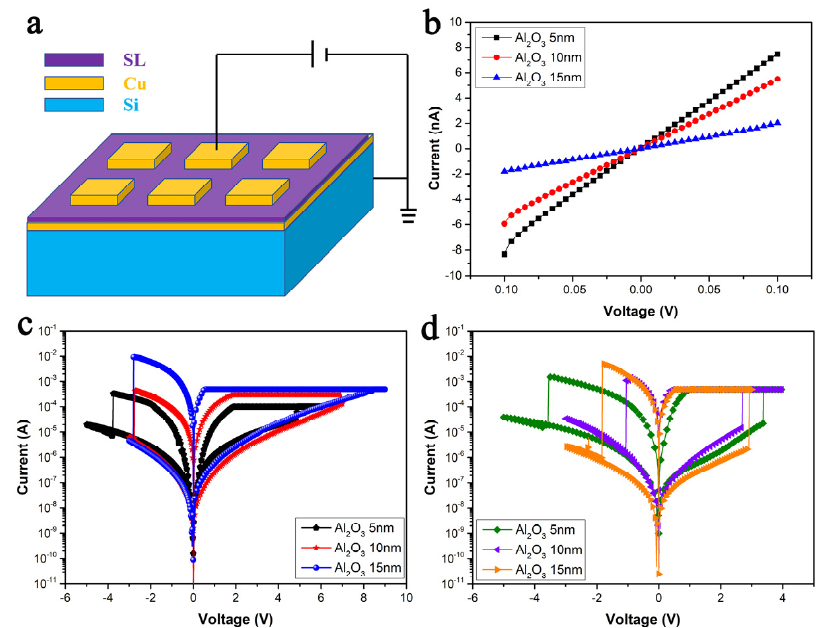
Figure 1. The structure diagram ( a ) of the Cu electrode-based RRAM device. The initial resistance ( b ), forming process ( c ), and RS behaviour ( d ) of the Cu/Al 2 O 3 /Cu devices with 5 nm, 10 nm, and 15 nm Al 2 O 3 .